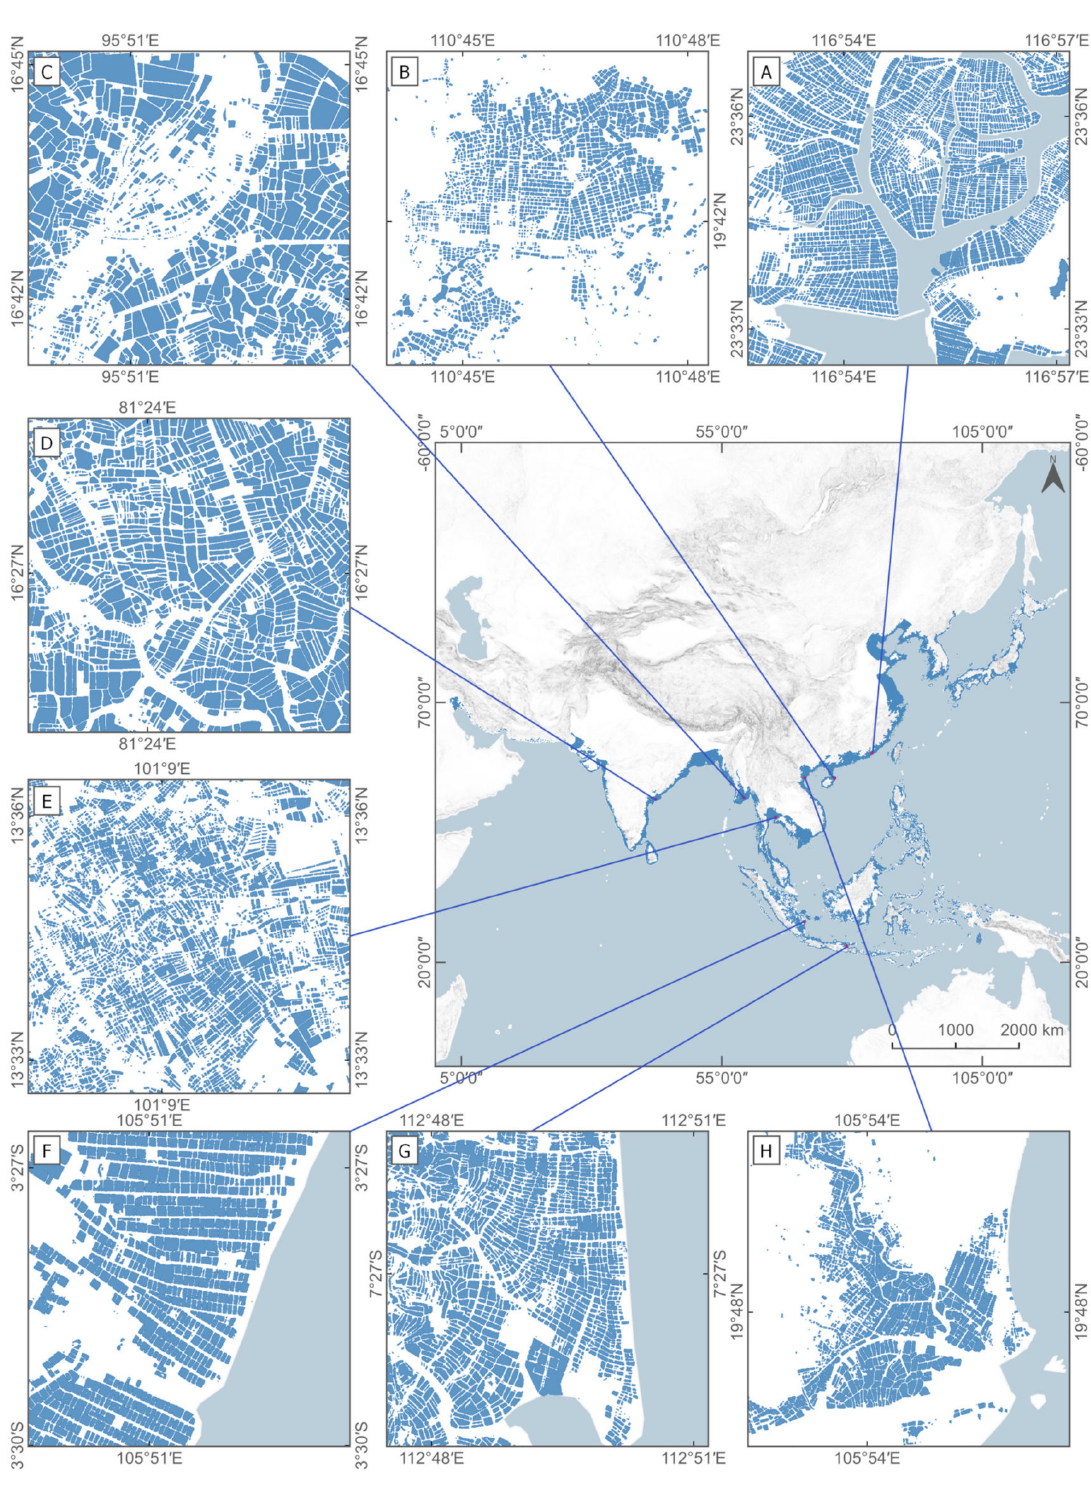
Figure 9. Extracted aquaculture ponds for the entire coastal zone of Asia. Coastal spots: ( A ) Guang- dong Province, China; ( B ) Hainan Province, China; ( C ) Irrawaddy Delta, Myanmar; ( D ) Andhra Pradesh state, India; ( E ) Chachoengsao Province, Thailand; ( F ) Sumatra, Indonesia; ( G ) Java, Indone- sia; ( H ) Red River Delta,